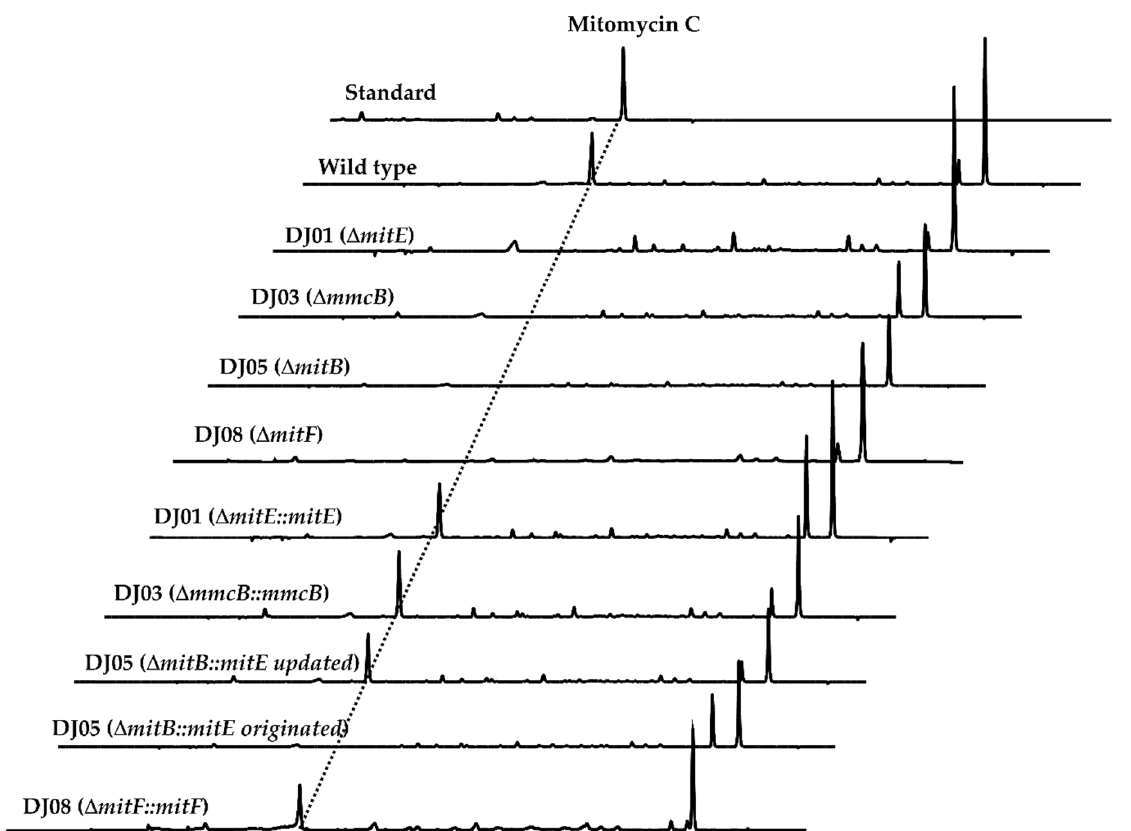
Figure 2. HPLC analysis results of the genetic recombinant strains.